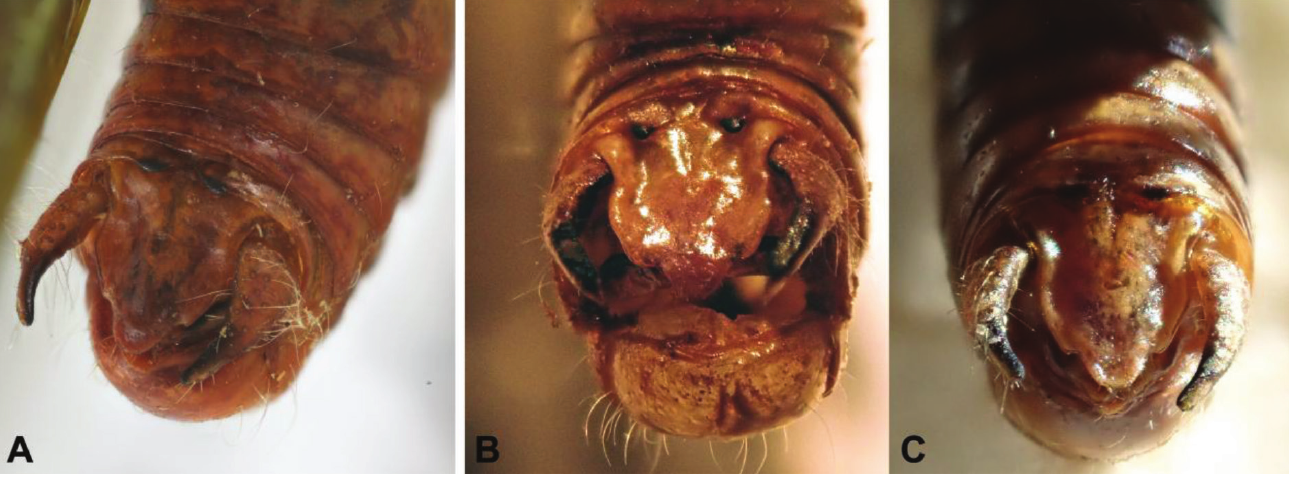
Fig. 4. Abdominal apices of male Physocrobylus species. A. P. burtti ; B. P. tessa ; and C. P. venetus sp. nov.